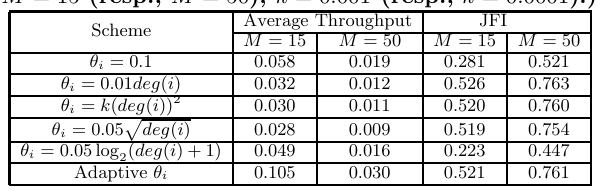
Table 1: Av. throughput and JFI for the adaptive algorithm. (For the scheme with θ i = k ( deg ( i )) 2 , for M = 15 (resp., M = 50 ), k = 0 . 001 (resp., k = 0 . 0001 ).)